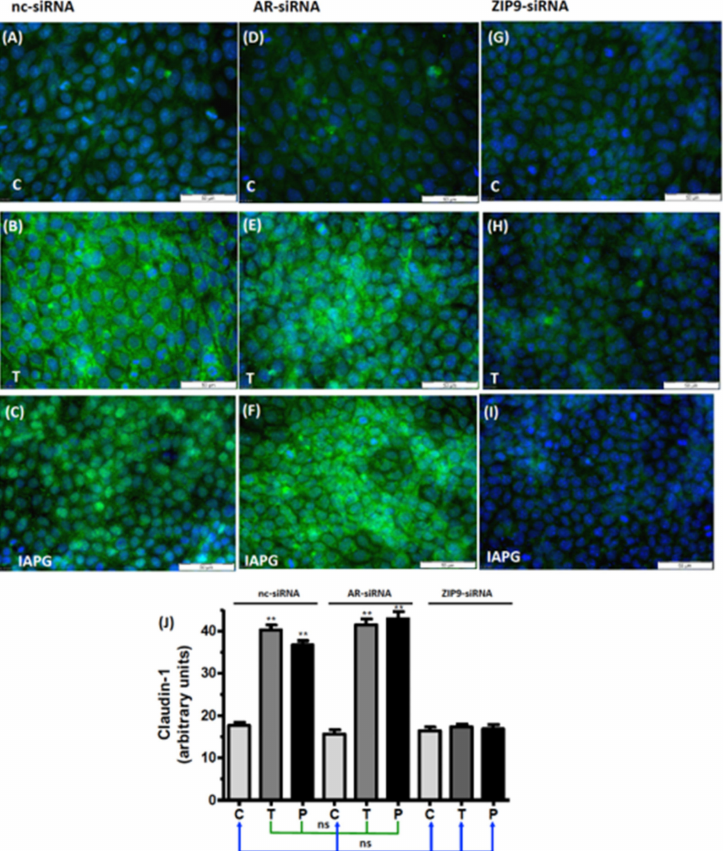
Figure 9. Detection of Cldn-1 by immunofluorescence. Incubation with vehicle (C), 10 nM testosterone (T), or 10 µ M IAPG (P) was carried out for 24 h. Nuclei are shown as blue and Cldn-1 as green. ( A – C ) Cldn-1 in cells treated with nc-siRNA. ( D – F ) Cldn-1 in cells treated with AR-siRNA. ( G – I ) Cldn- 1 in cells treated with ZIP9-siRNA. (J) Statistical analysis of green fluorescence shown in panels A-I